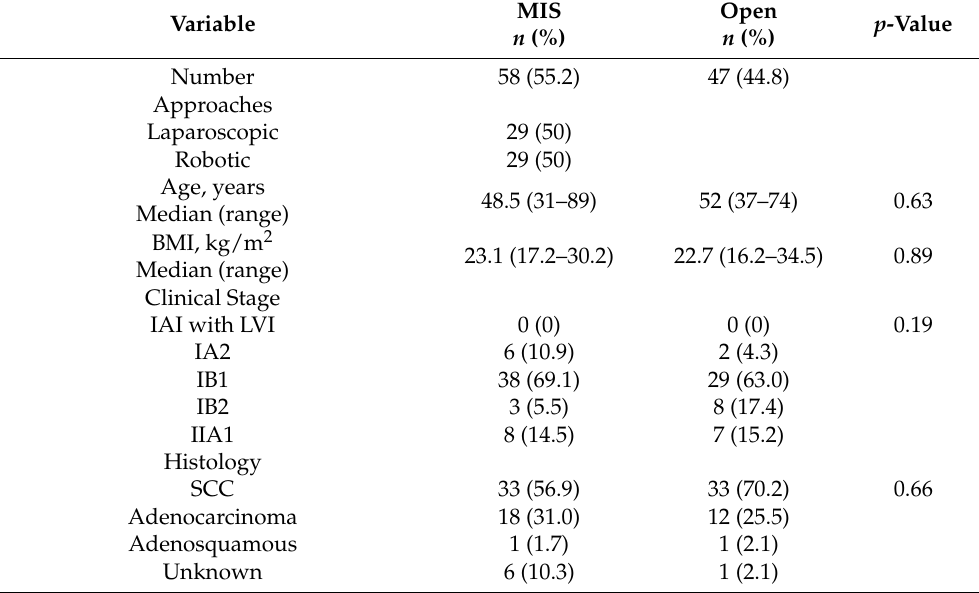
Table 1. Baseline clinicopathologic characteristics of minimally invasive surgery (MIS) versus open radical